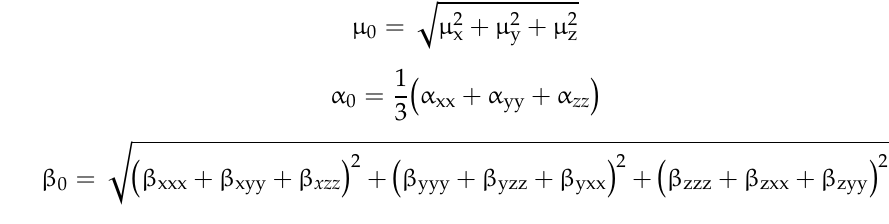
Table7. Dipolemoment, linearpolarizabilityandstatichyperpolarizabilitycomponentsingaseousstate. Gaseous Chloroform Parameter